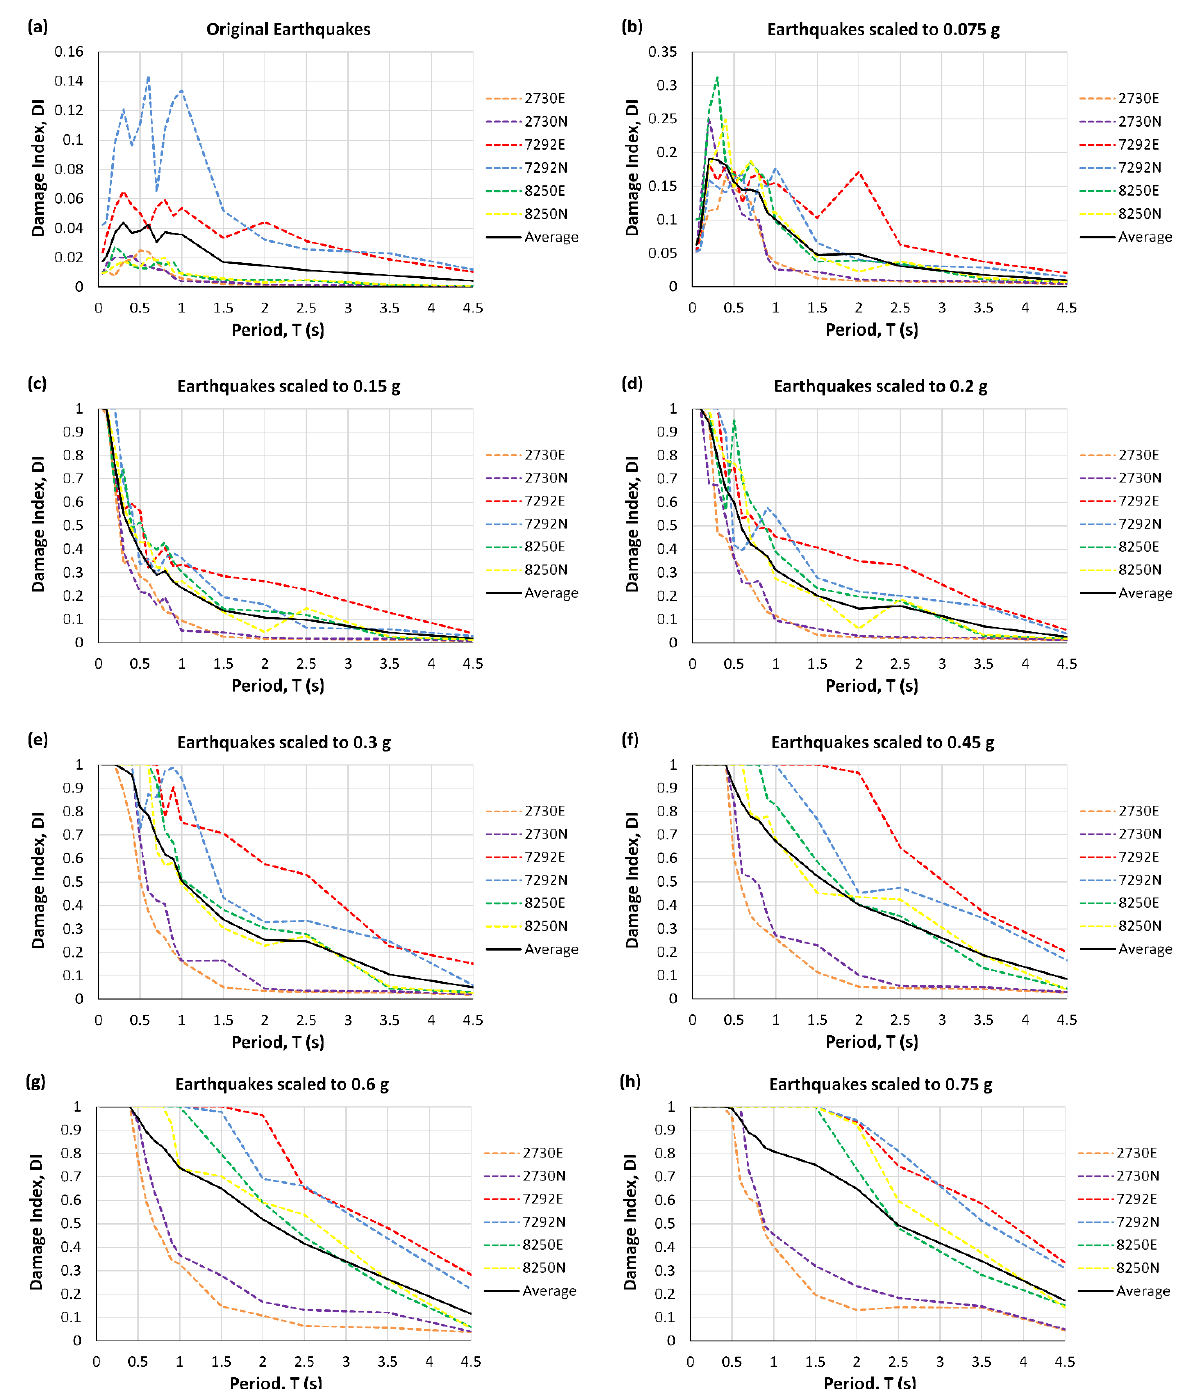
Figure 3. Park and Ang [18] DI spectral functions for seismic records: ( a ) original, ( b ) scaled to 0.075 g, ( c ) scaled to 0.15 g, ( d ) scaled to 0.2 g, ( e ) scaled to 0.3 g, ( f ) scaled to 0.45 g, ( g ) scaled to 0.6 g, and ( h ) scaled to 0.75 g.